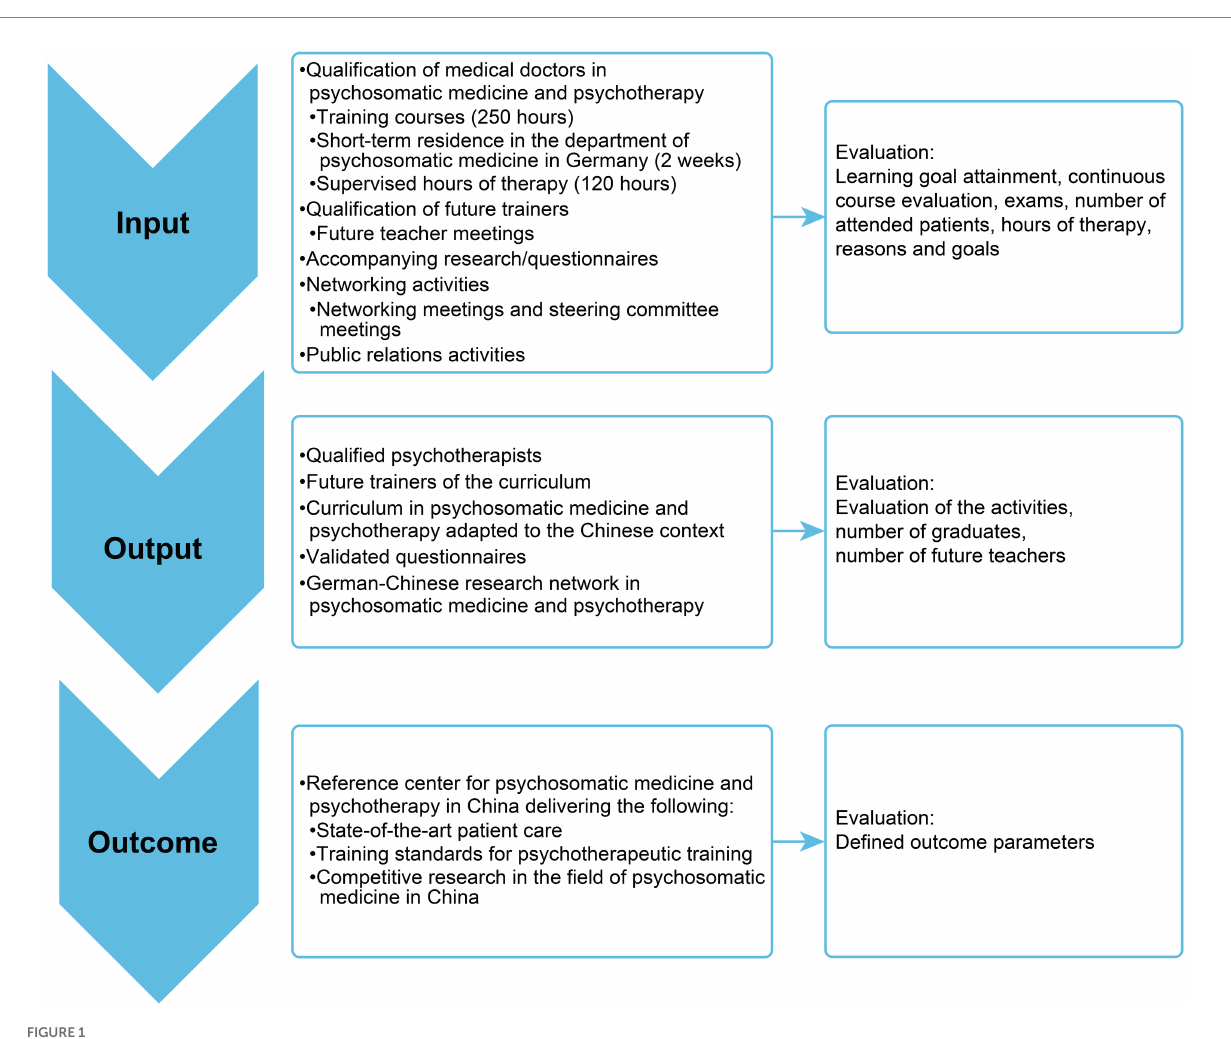
FIGURE 1 Outputs and